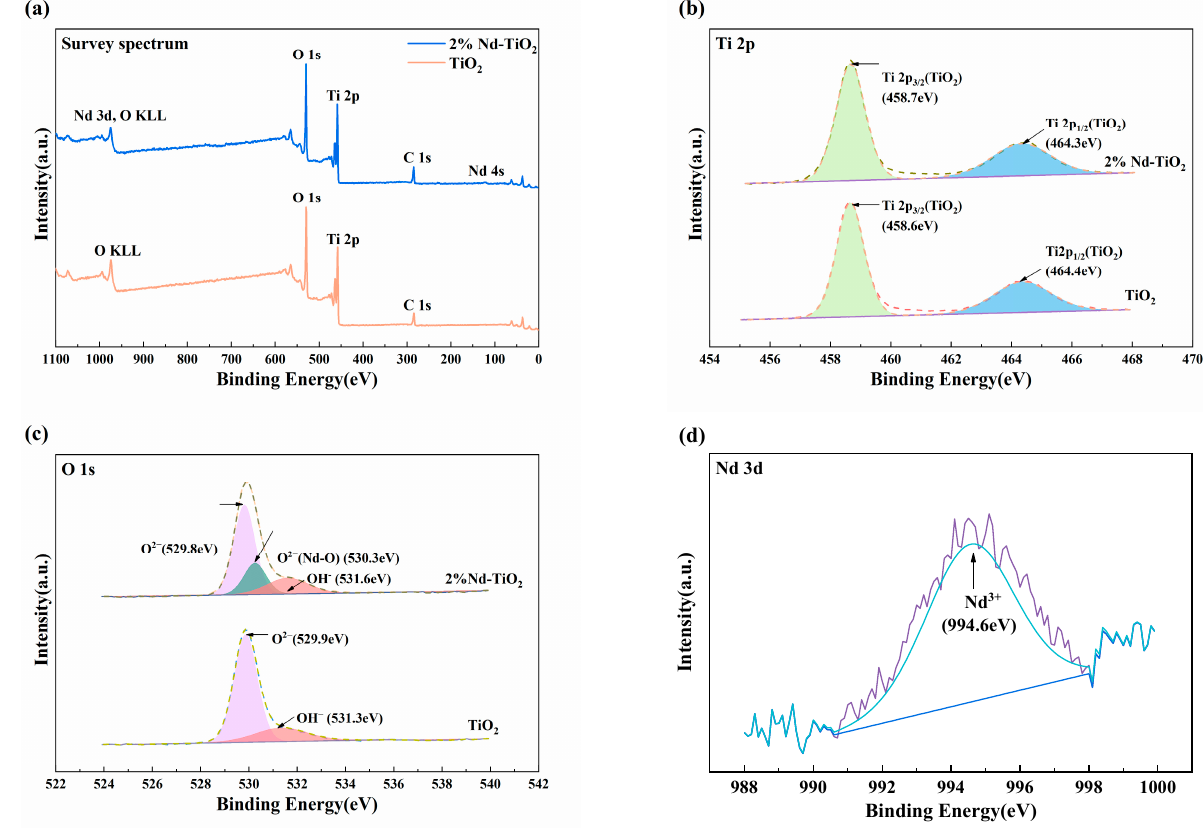
Figure 3. XPS spectra of 2%Nd-TiO 2 and TiO 2 NPs. ( a ) Survey spectrum; high-resolution XRS spectra of ( b ) Ti 2p, ( c ) O 1s, and ( d ) Nd 3d.